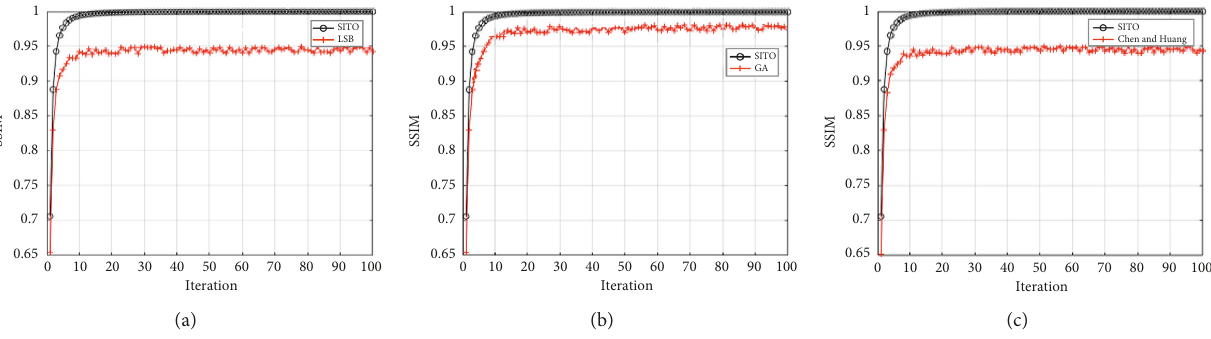
Figure 9: Comparison of SSIM variation with (a) LSB, (b) GA, and (c) the method of Chen and Huang